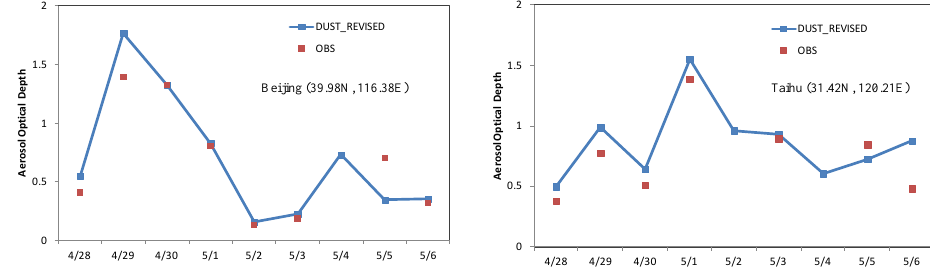
Fig. 3. Comparison of simulated daily average AOD with observations at two AERONET sites, 28 April to 6 May.